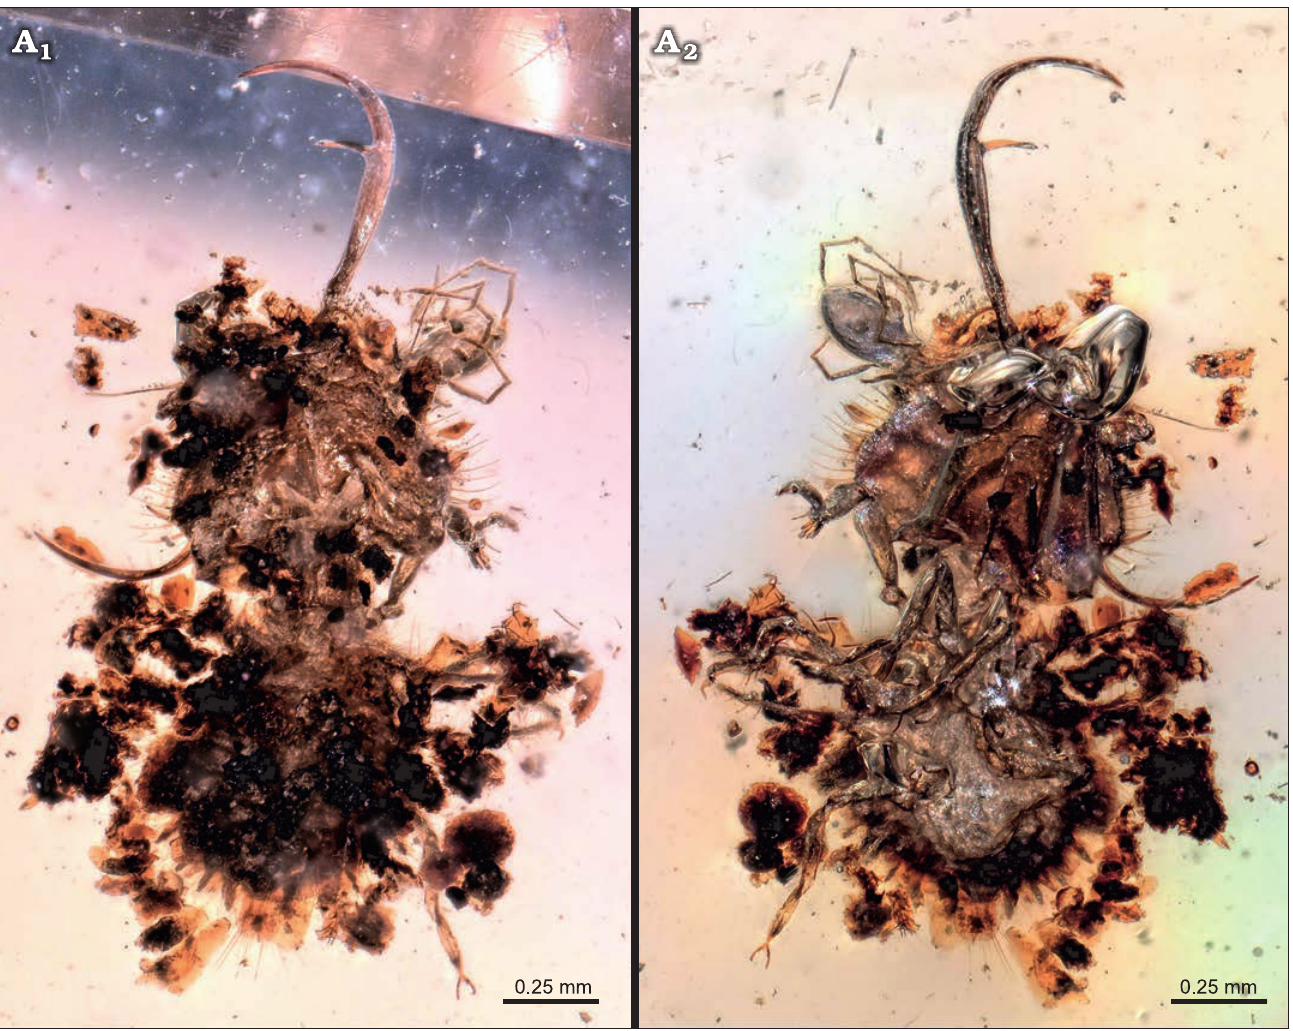
Fig. 2. SNSB-BSPG 2020 XCIII 18 containing a neuropteran larva with attached mite from Hukawng Valley, Kachin State, Myanmar; Turonian– Cenomanian, Cretaceous, 90–100 mya; in dorsal (A 1 ) and ventral (A 2 )